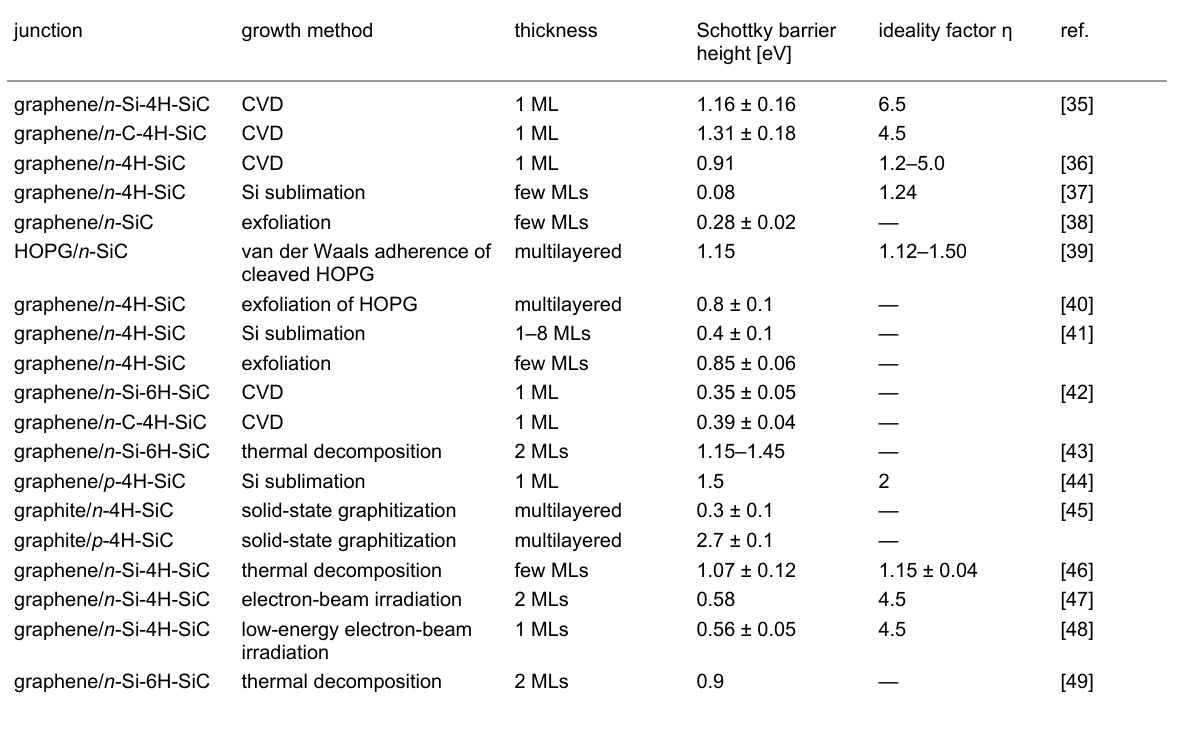
Table 1: A review of existing literature on fabrication method and properties of the graphene/SiC Schottky junction.